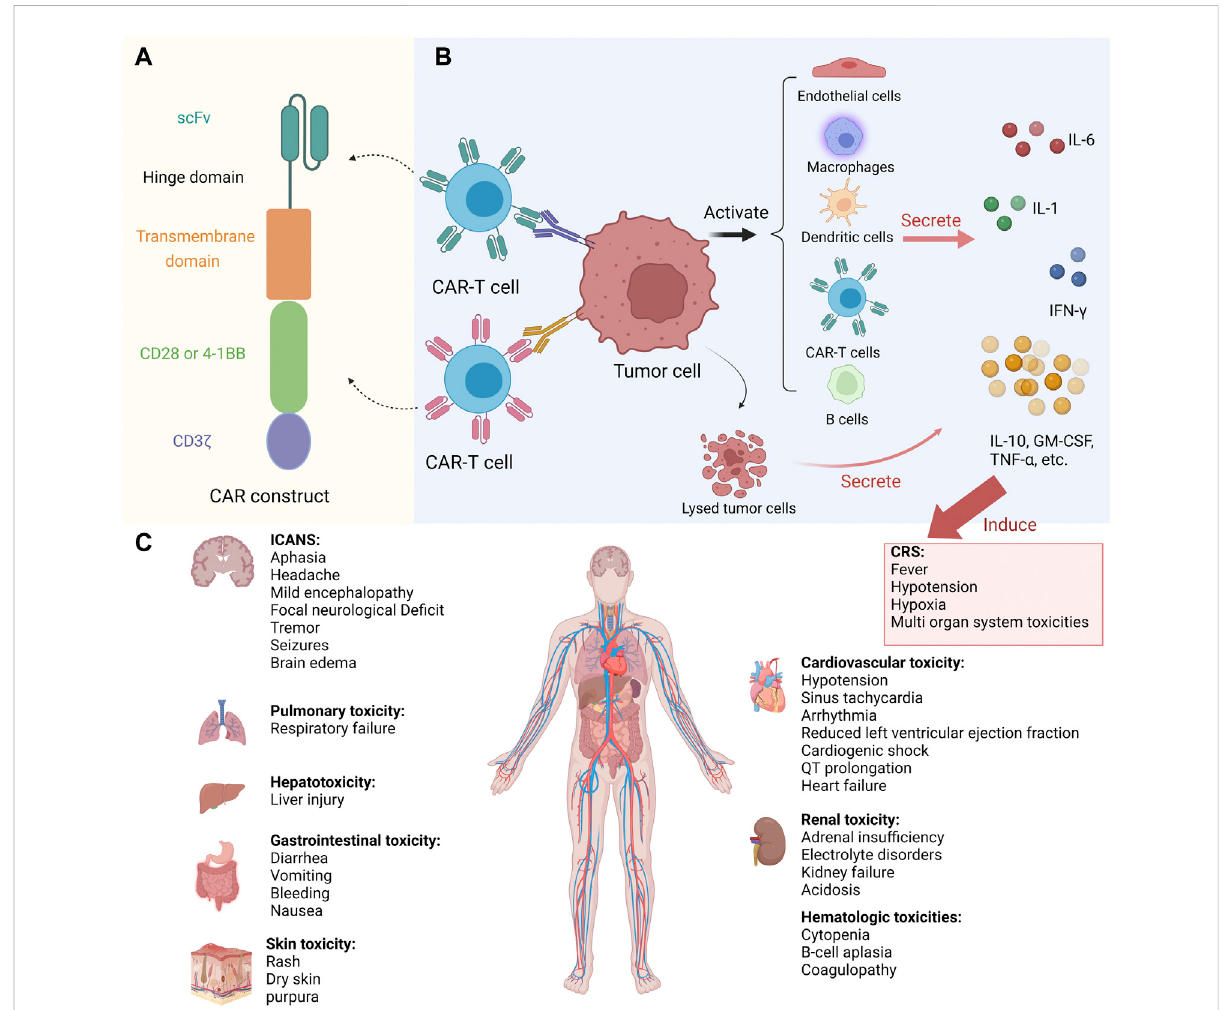
FIGURE 1 ToxicitiesduringCAR-Ttherapy. (A) ThestructureofCAR. (B) PathogenesisofCRS. (C) OrgansystemictoxicitiesinducedbyCRS.Abbreviations: CAR, chimeric antigen receptor; CRS, cytokine release syndrome; ICANS, immune effector cell-associated neurotoxicity syndrome; scFv, single- chain variable fragment; IL, interleukin; IFN- γ , interferon gamma; GM-CSF, granulocyte macrophage colony-stimulating factor; TNF- α , tumor necrosis factor alpha. This fi gure created with